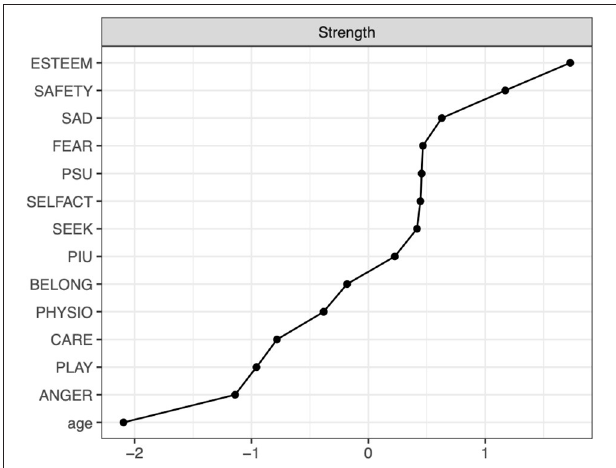
FIGURE 2 | Centrality plots denoting standardized strength